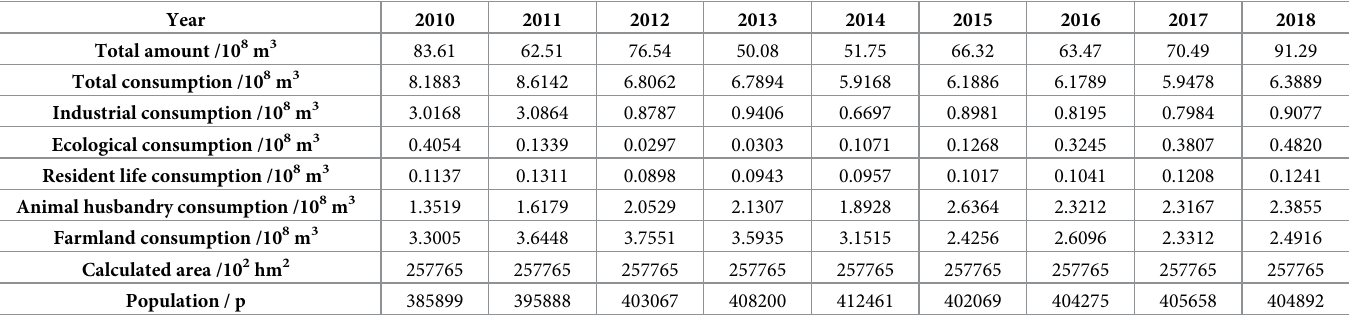
Table 2. Water yield and socio-economic data of water resources in the Qaidam Basin